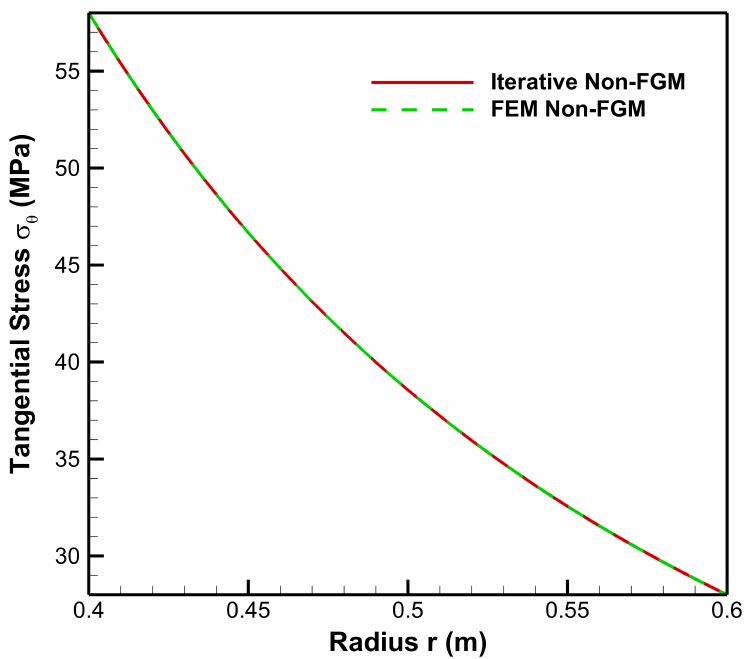
Figure 17. Comparison of tangential stress along the radius of the cylinder under internal pressure, P a = 50 MPa and external pressure, P b = 20 MPa.